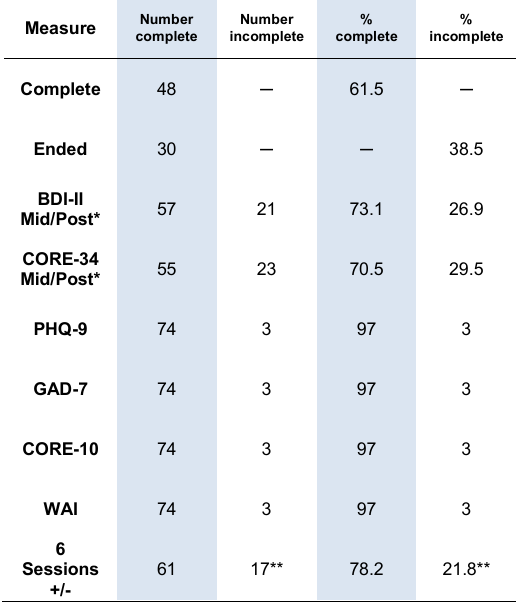
Table 2: Participants and data completeness